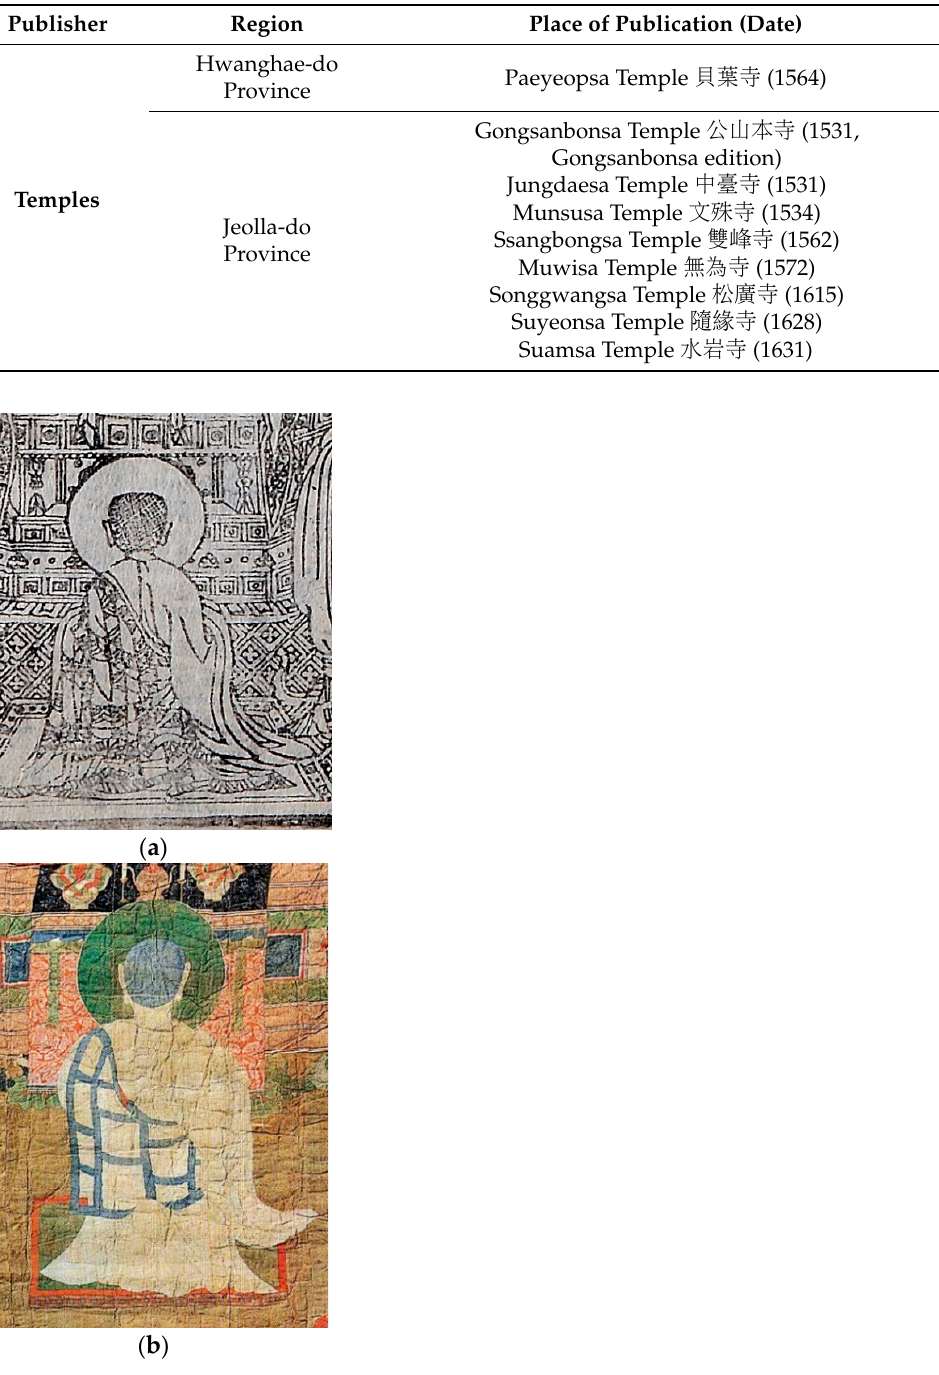
Table 2. Joseon Lotus Sutra print editions featuring the Listener in monk form (before the mid- seventeenth century).